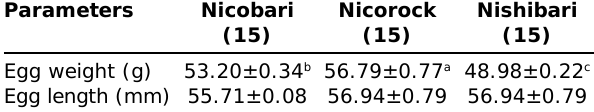
Table-2: Egg quality traits of Nicobari and Cross Nicobari fowl under intensive system of management. Parameters